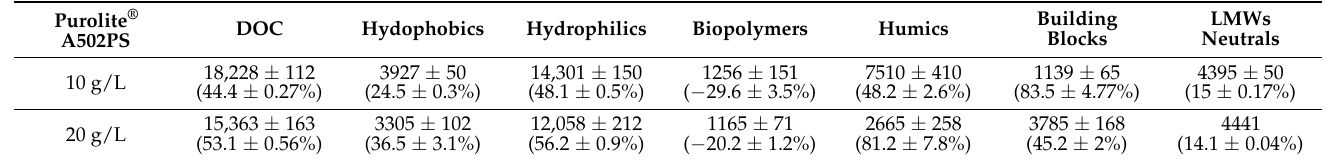
Table 5. Removal of Organic fractions by Purolite ® A502PS (Dosages 10 g/L and 20 g/L). Purolite ®